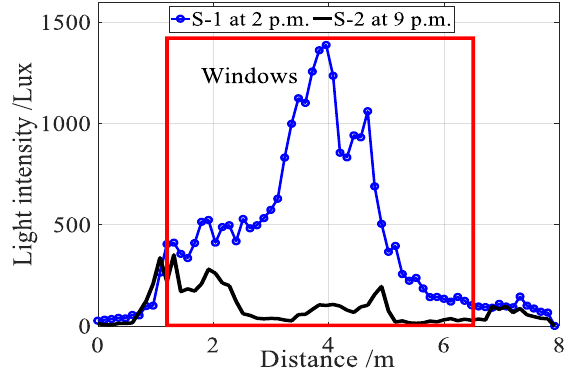
Figure 4. User Diversity. ( a ) Different heights; ( b ) Different attitudes.